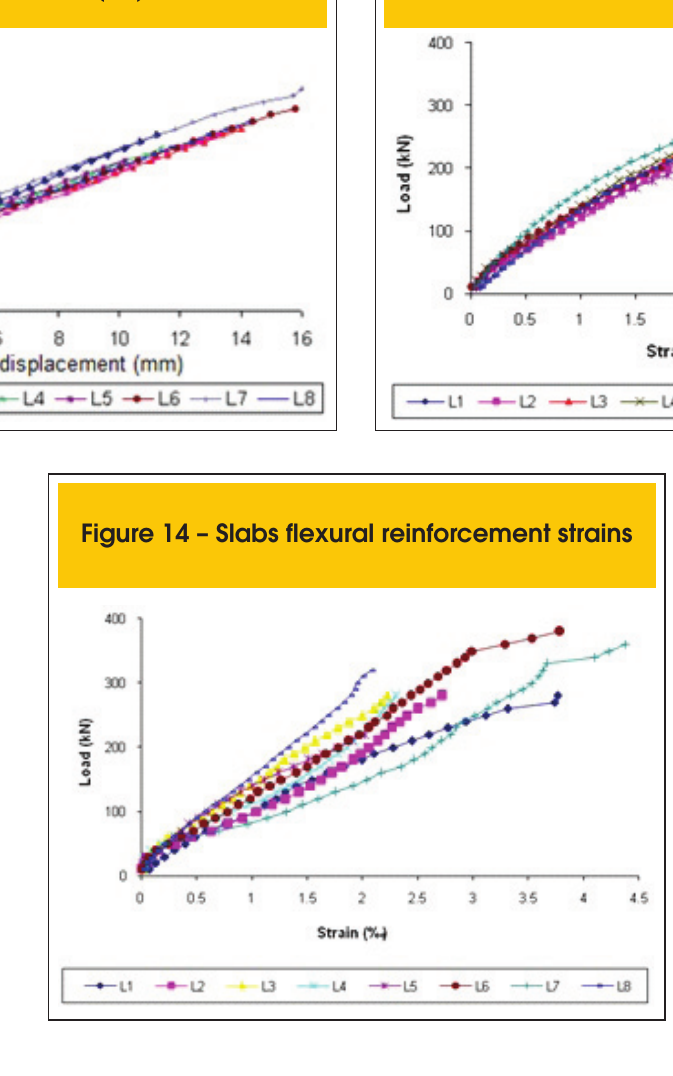
Figure 12 – Slabs middle span vertical displacements (D4)